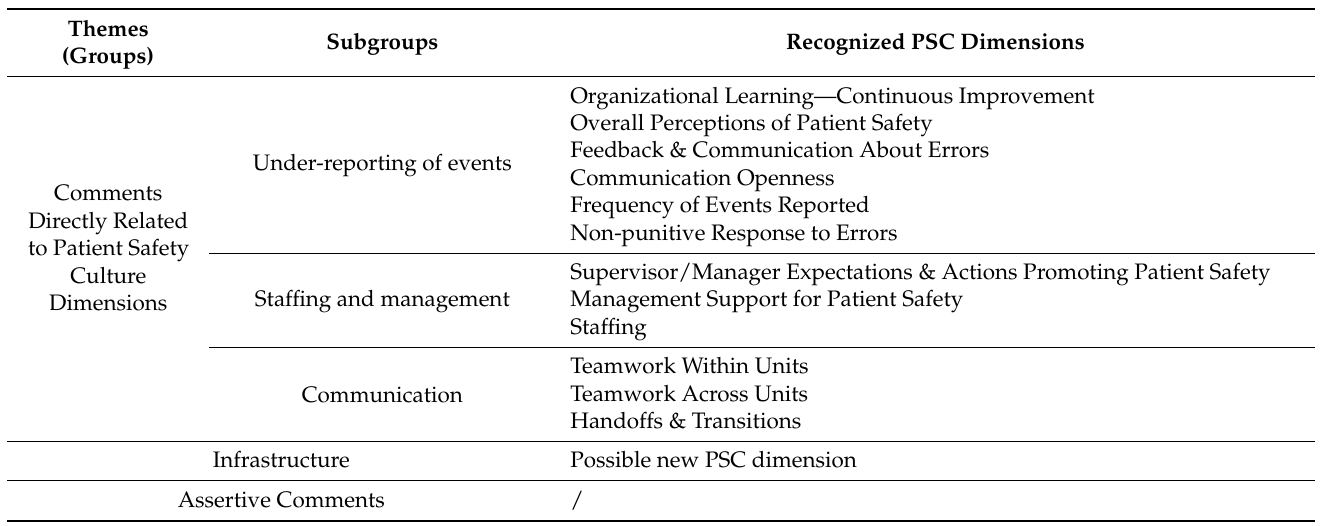
Table 3. PSC dimensions grouped in the three subgroups identified through the qualitative